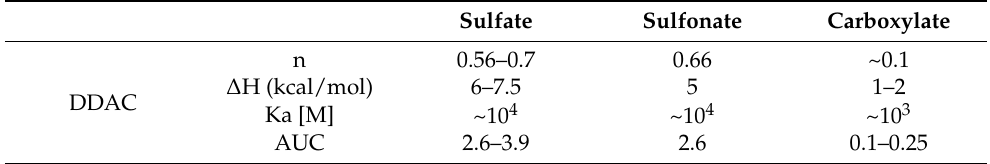
Table 3. The thermodynamic parameters calculated from ITC data (presented in Figure 4) of the cationic-anionic binding process, including n, Ka, and ∆ H for each functional group combination. Sulfate Sulfonate Carboxylate n DDAC